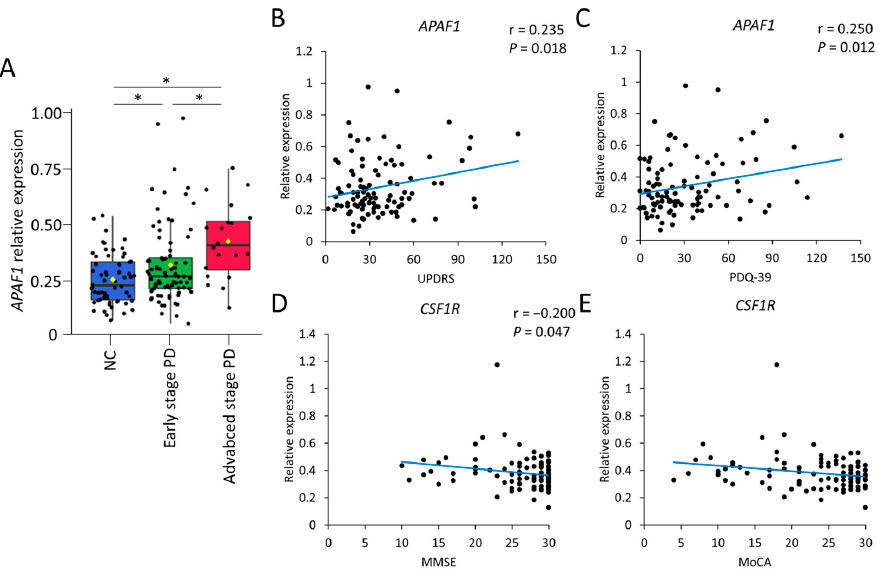
Figure 1. ( A ) Difference in expression level of APAF1 between Parkinson’s disease (PD) patients